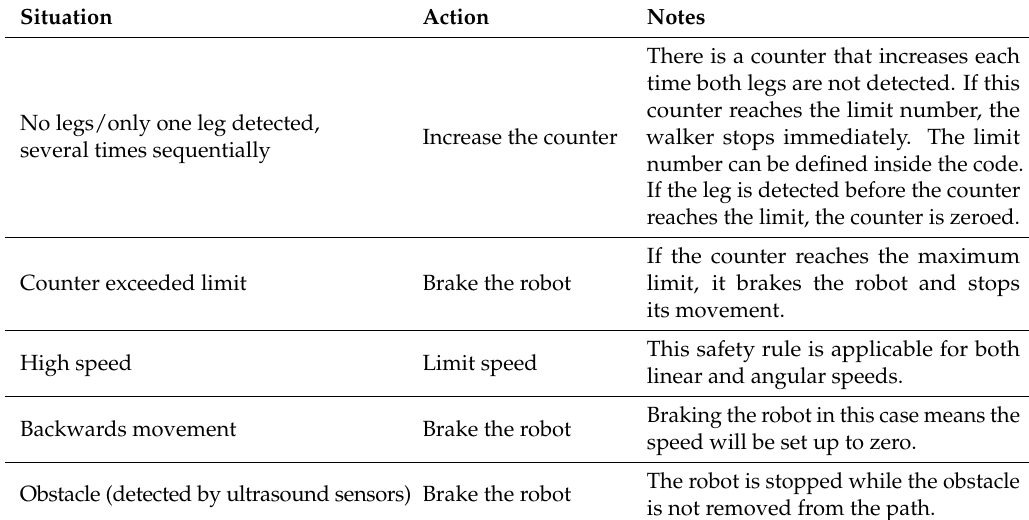
Table 3. Safety rules for the smart walker.